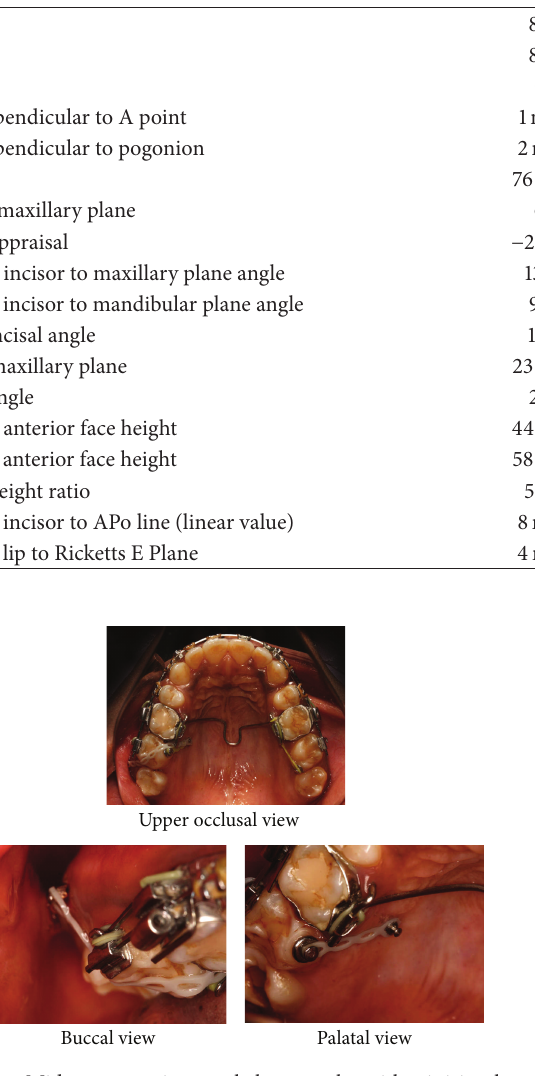
Figure5:Mid-treatmentintraoralphotographs:withmini-implants